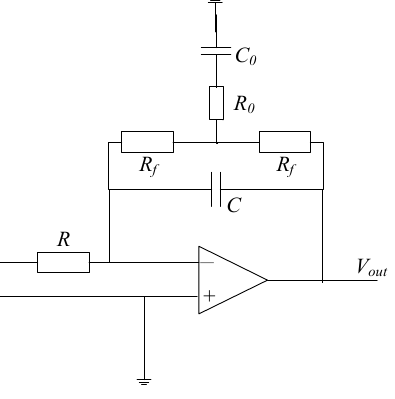
Figure 9. The schematic diagram of integrator.